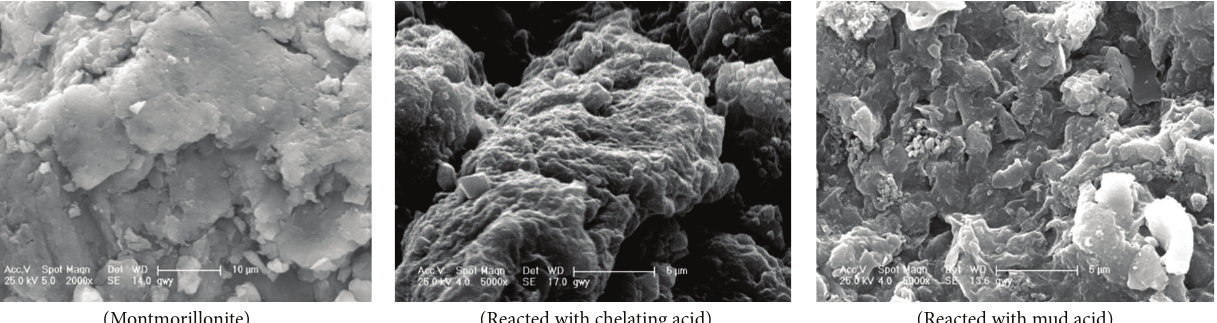
Figure 3: SEM of montmorillonite after the reaction with acid.